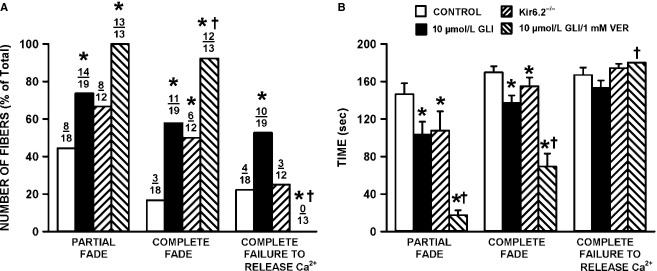
The lack of KATP channel activity significantly increased the number of fibers with partial and complete fade. (A) Number of fibers with partial, complete fade and complete failure to release Ca2+ are as defined in Figure1. Numbers at the top of each bar represent the number of fibers with fade or failure over total number of tested fibers. (B) Mean times that fibers were able to maintain a Ca2+ plateau phase while being stimulated. For complete failure, partial and complete fade, we recorded the first time it occurred. In the absence of complete failure, partial or complete fade, a value of 180 sec was recorded. Statistical test in A was the Fishers Exact test and in B an ANOVA and L.S.D. using a probability of P < 0.05. *Proportions of fibers in A or mean time value in B were significantly different from the mean time value of control fibers, †Proportions of fibers in A or mean time value in B were significantly different from the mean time value for glibenclamide-exposed fibers.